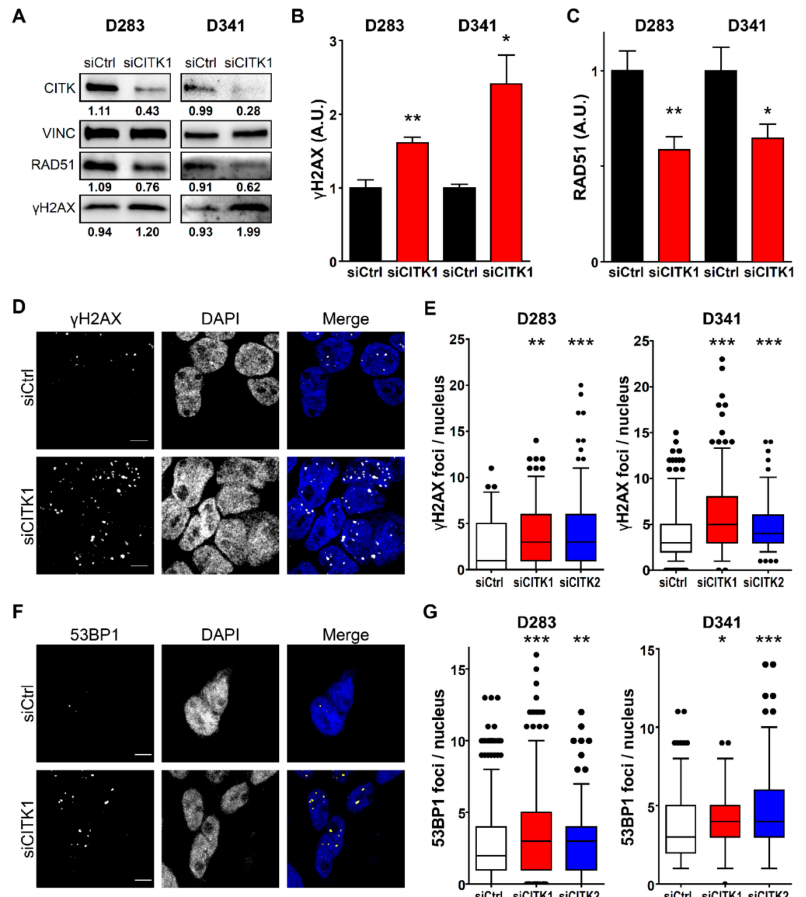
Figure 3. CITK knockdown induces RAD51 reduction and DNA-damage accumulation in G3 / G4 MB cells. ( A ) Western blot analysis of total lysate from D283 and D341 cell lines, 100 and 72 h after treatment with siCtrl or siCITK1. The levels of CITK, RAD51 and γ H2AX were analyzed. The internal loading control was vinculin (VINC). ( B , C ) Quantification of the relative density of γ H2AX and RAD51 in D283 and D341 after CITK knockdown. ( D , F ) Representative images of D283 cells stained with DAPI and anti- γ H2AX ( D ) or anti-53BP1 ( F ) antibodies 100 h after transfection with nontargeting or siCITK1. ( E , G ) Quantification of γ H2AX ( E ) and 53BP1 ( G ) nuclear foci in D283 and D341 cells, treated as above. All quantifications were based on at least five independent biological replicates. Error bars, SEM. *, p < 0.05; **, p < 0.01; two-tailed Student’s t -test for blots. *, p < 0.05; **, p < 0.01, ***, p < 0.001 Mann–Whitney U test for γ H2AX and 53BP1 foci. Scale bars, 5 µ m. A.U., arbitrary